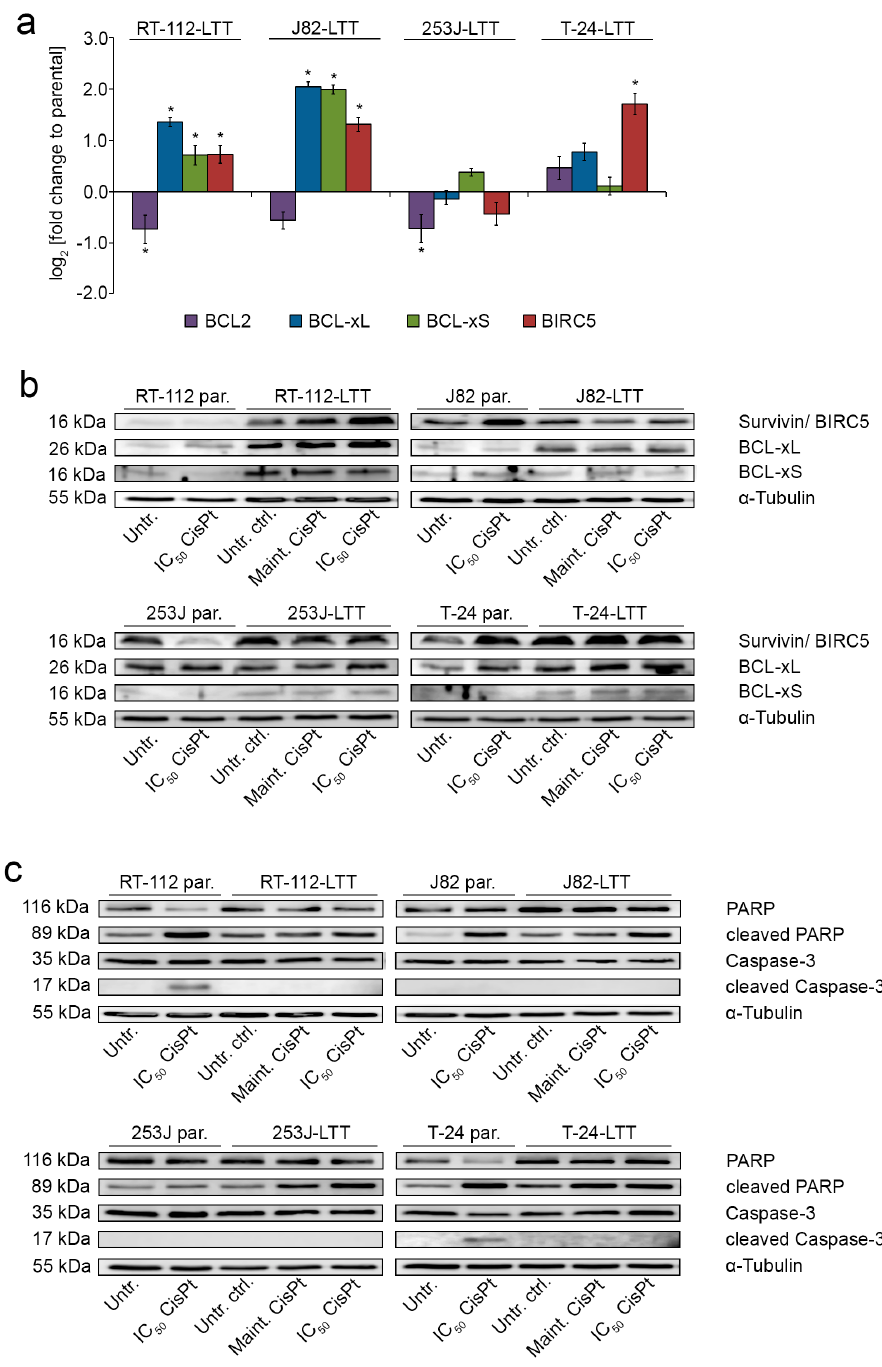
Figure 4. Cont. Figure 4.